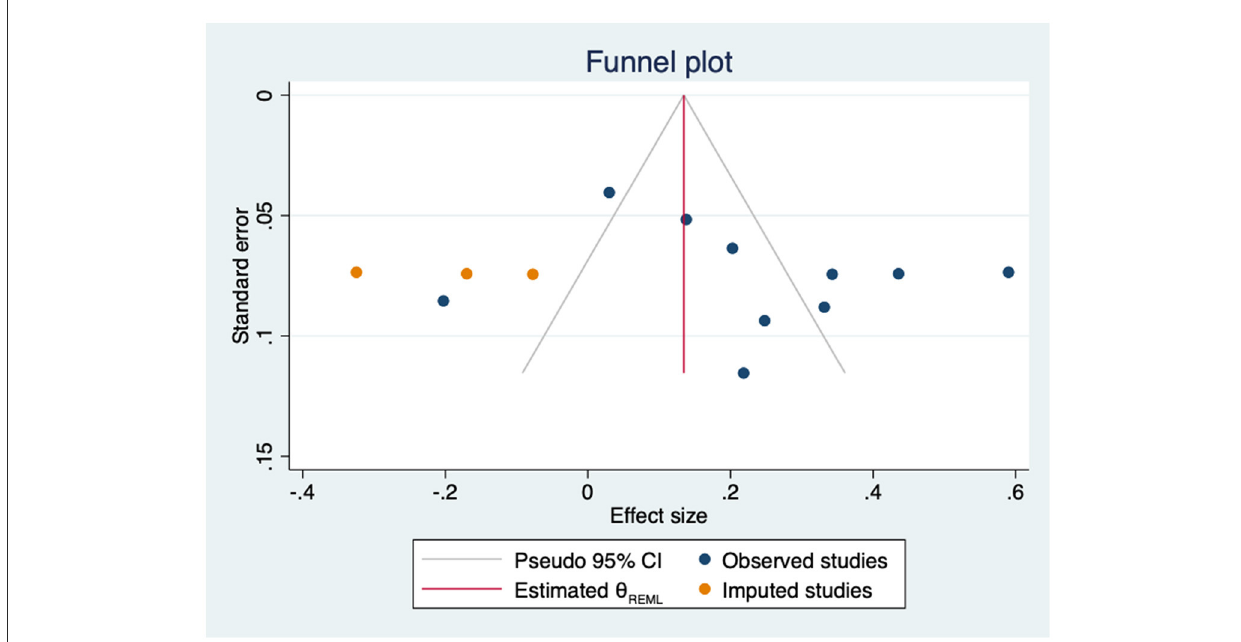
FIGURE12 Funnel plot with trim-and-fill imputations for the association between empowerment and mental QoL.